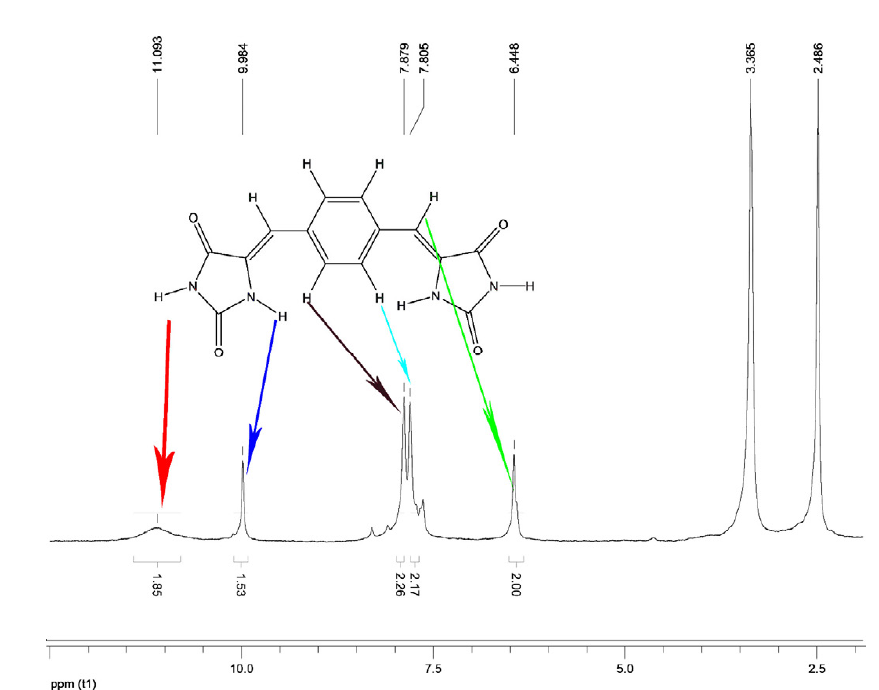
Fig. 1. H NMR of ligand (imidazolidone) Figure 1. 1 H NMR of ligand (imidazolidone) DMSO